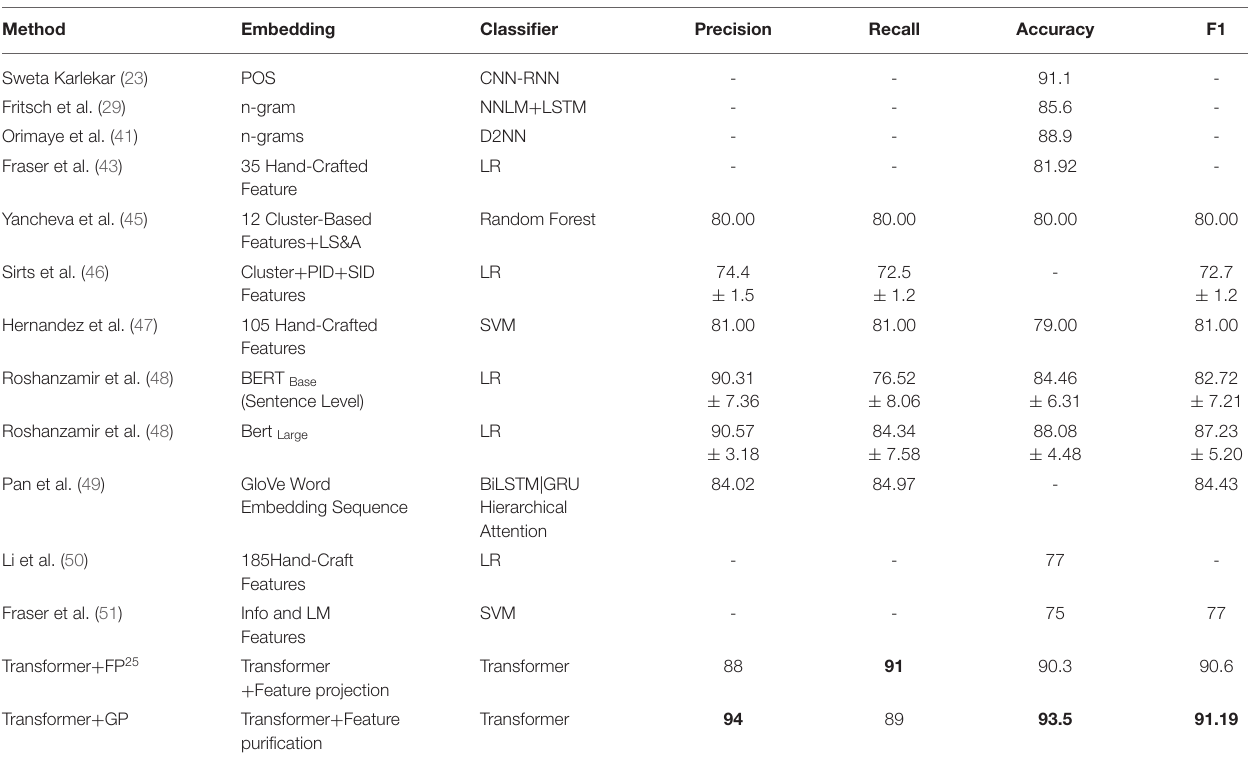
TABLE 2 | AD vs. CTRL classification scores on Pitt